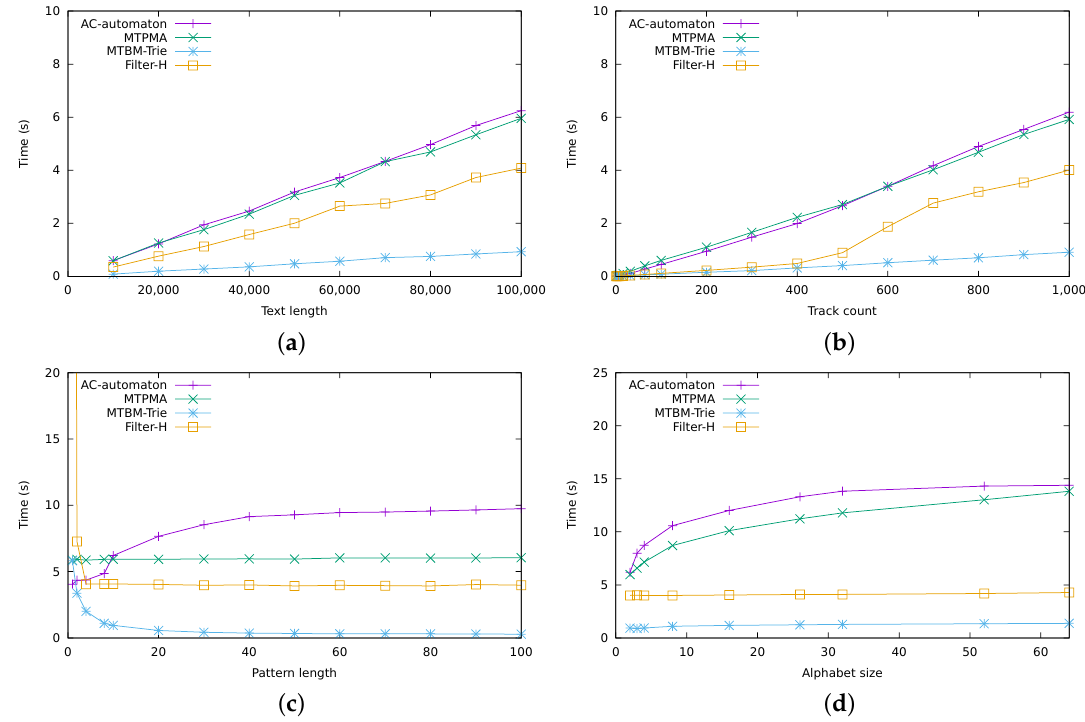
Figure 7. Comparison of the running time of the AC-automaton-based algorithm with the proposed algorithms for permuted pattern matching with respect to ( a ) the text length, ( b ) the track count, ( c ) the pattern length, and ( d ) the alphabet